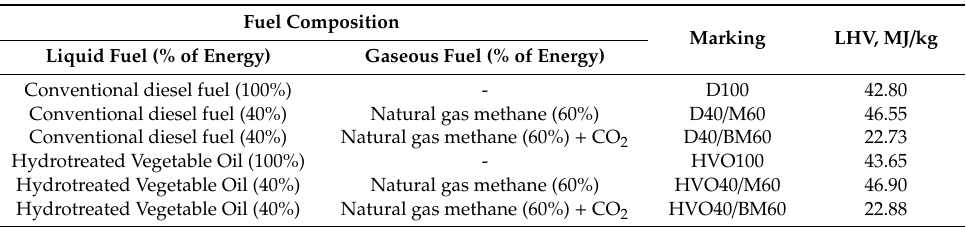
Table 4. Fuels used during the test and their